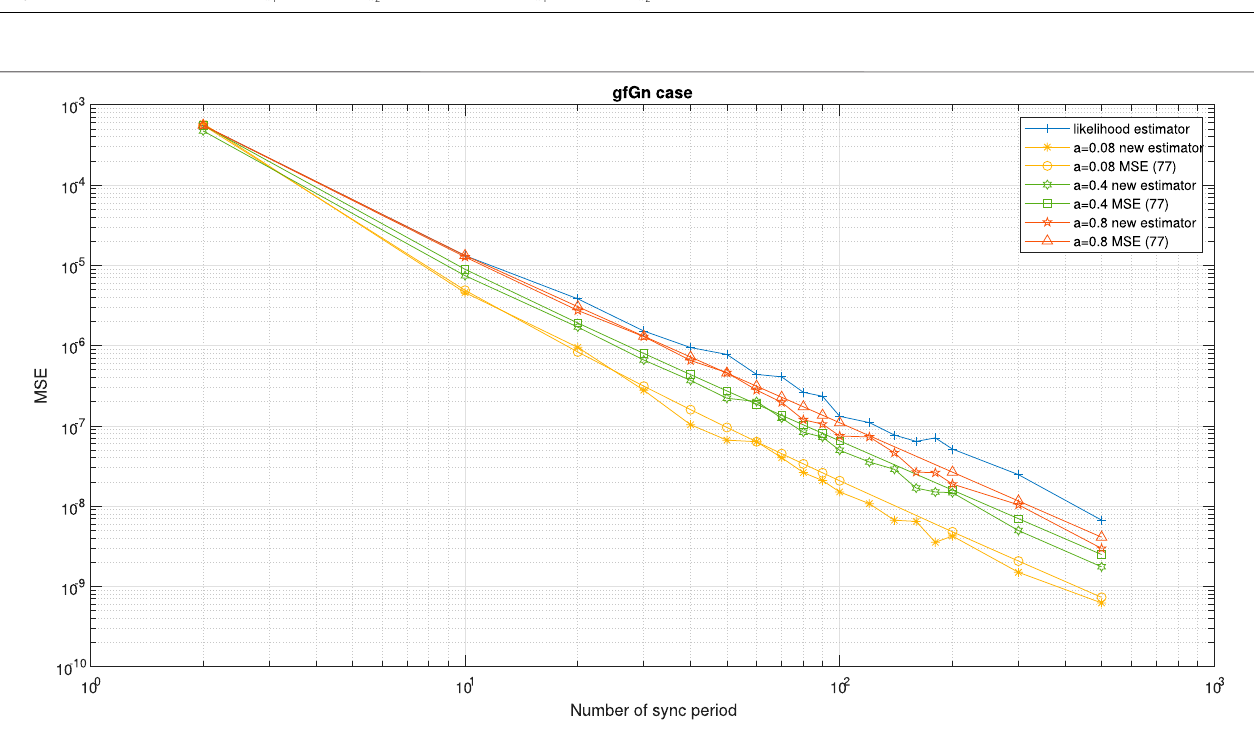
(cid:1) 0 . 8 ms , σ ω (cid:1) 0 . 5 ms , case 2 : σ ω (cid:1) 0 . 8 ms , σ ω (cid:1) 1 . 2 ms . The results were obtained for 100 Monte-Carlo trails. 1 2 1 2